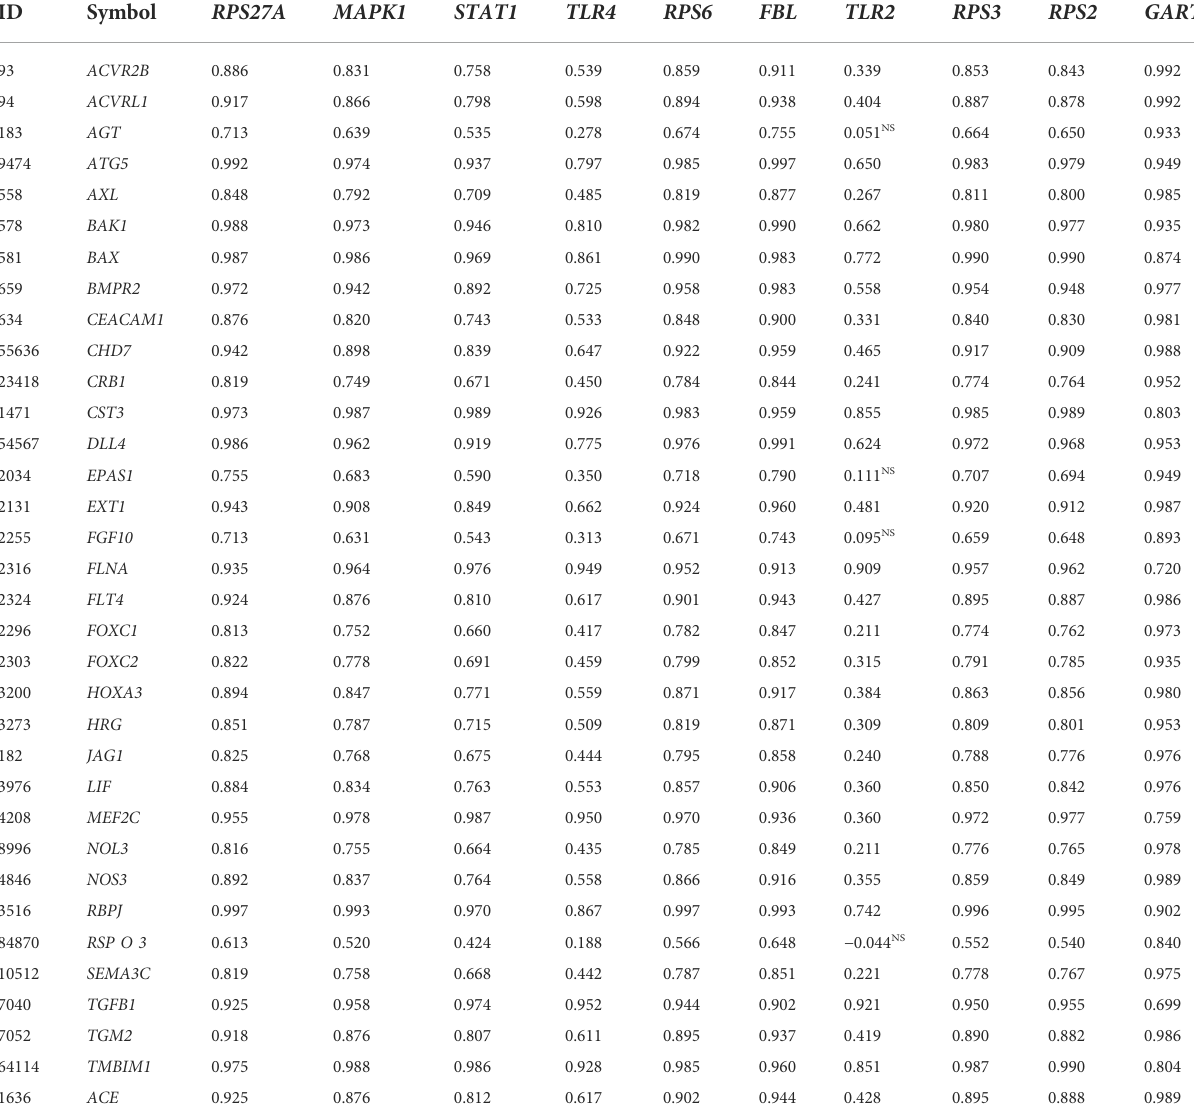
TABLE 6 The blood vessel remodeling genes are positively correlated with the expression levels of the top ten hub genes: RPS27A, MAPK1, STAT1, TLR4, RPS6, FBL, TLR2, RPS3, RPS2, and GART (Pearson ’ s correlation test, FDR < 0.05). ID Symbol